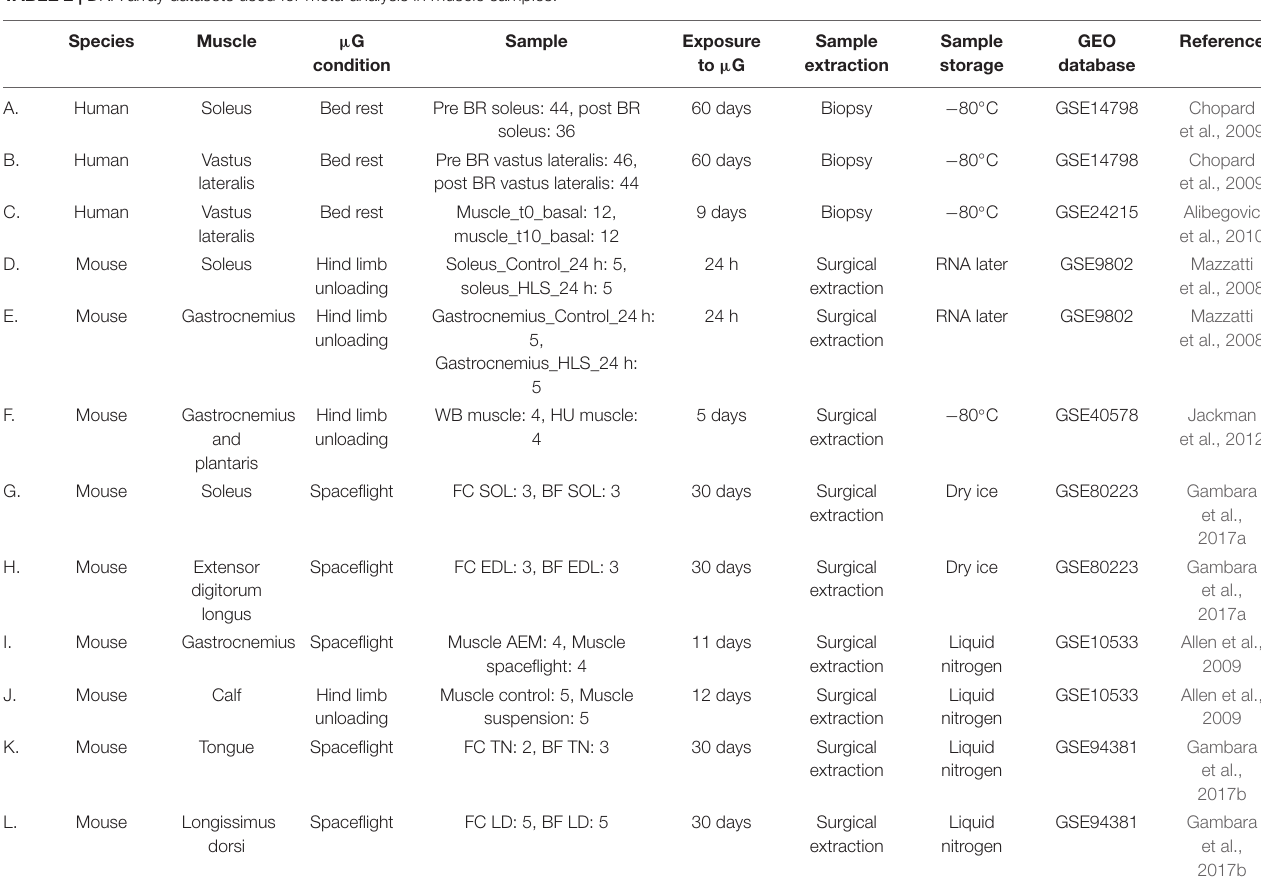
TABLE 2 | DNA array datasets used for meta-analysis in muscle